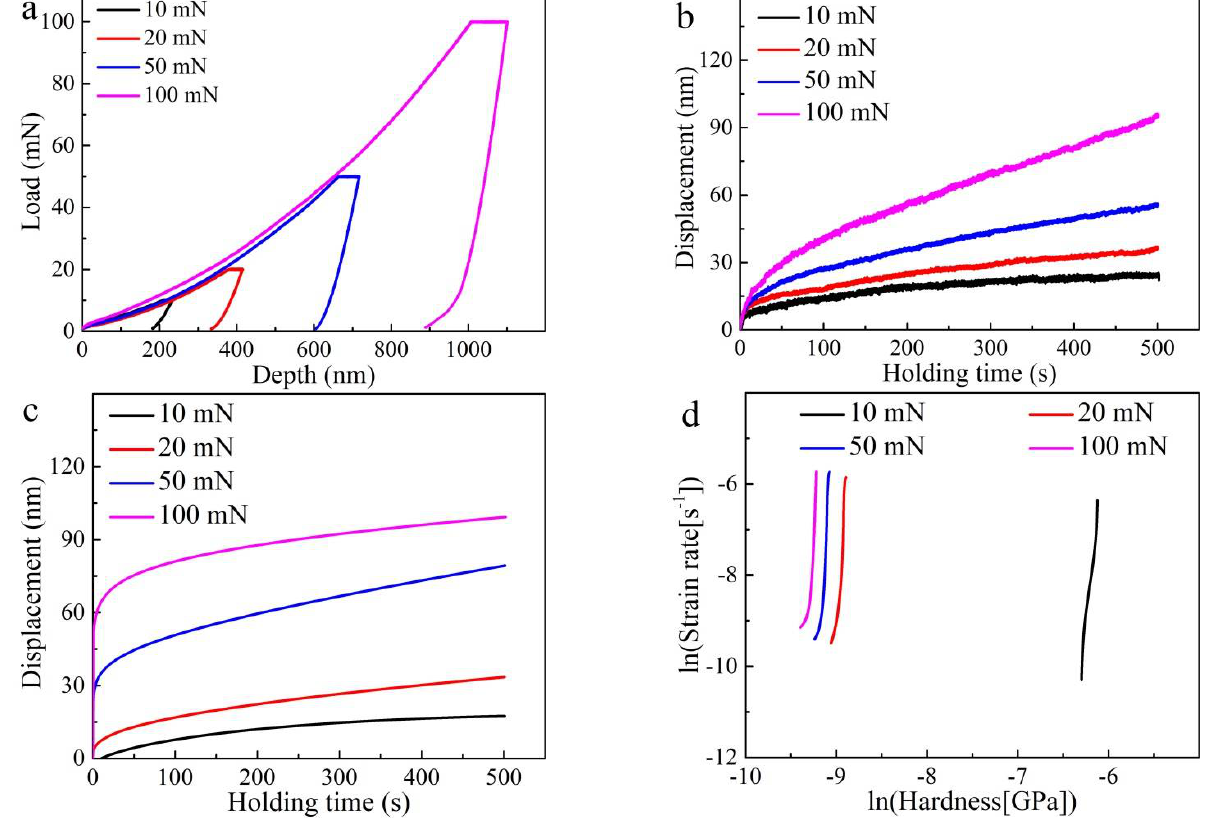
Figure 9. PBF-EB AM Ti6Al4V alloy with only the linear scanning strategy (sample A): ( a ) P–h curves under various maximum loads (10–100 mN); ( b ) experimental and ( c ) fitting creep displacement–time curves under various maximum loads (10–100 mN); ( d ) ln-ln plots of strain rate vs. nanoindentation stress under various maximum loads (10–100 mN).